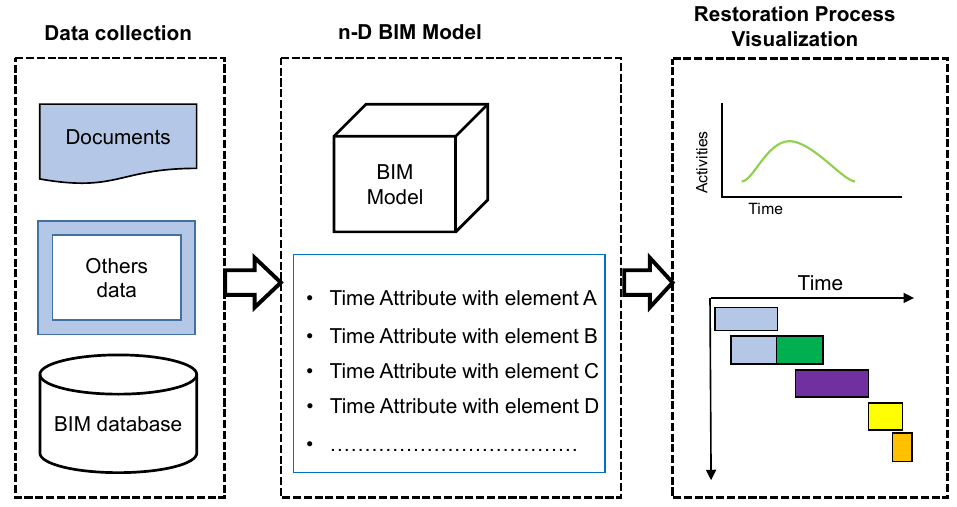
Figure 9. Restoration planning process supported by the proposed framework.